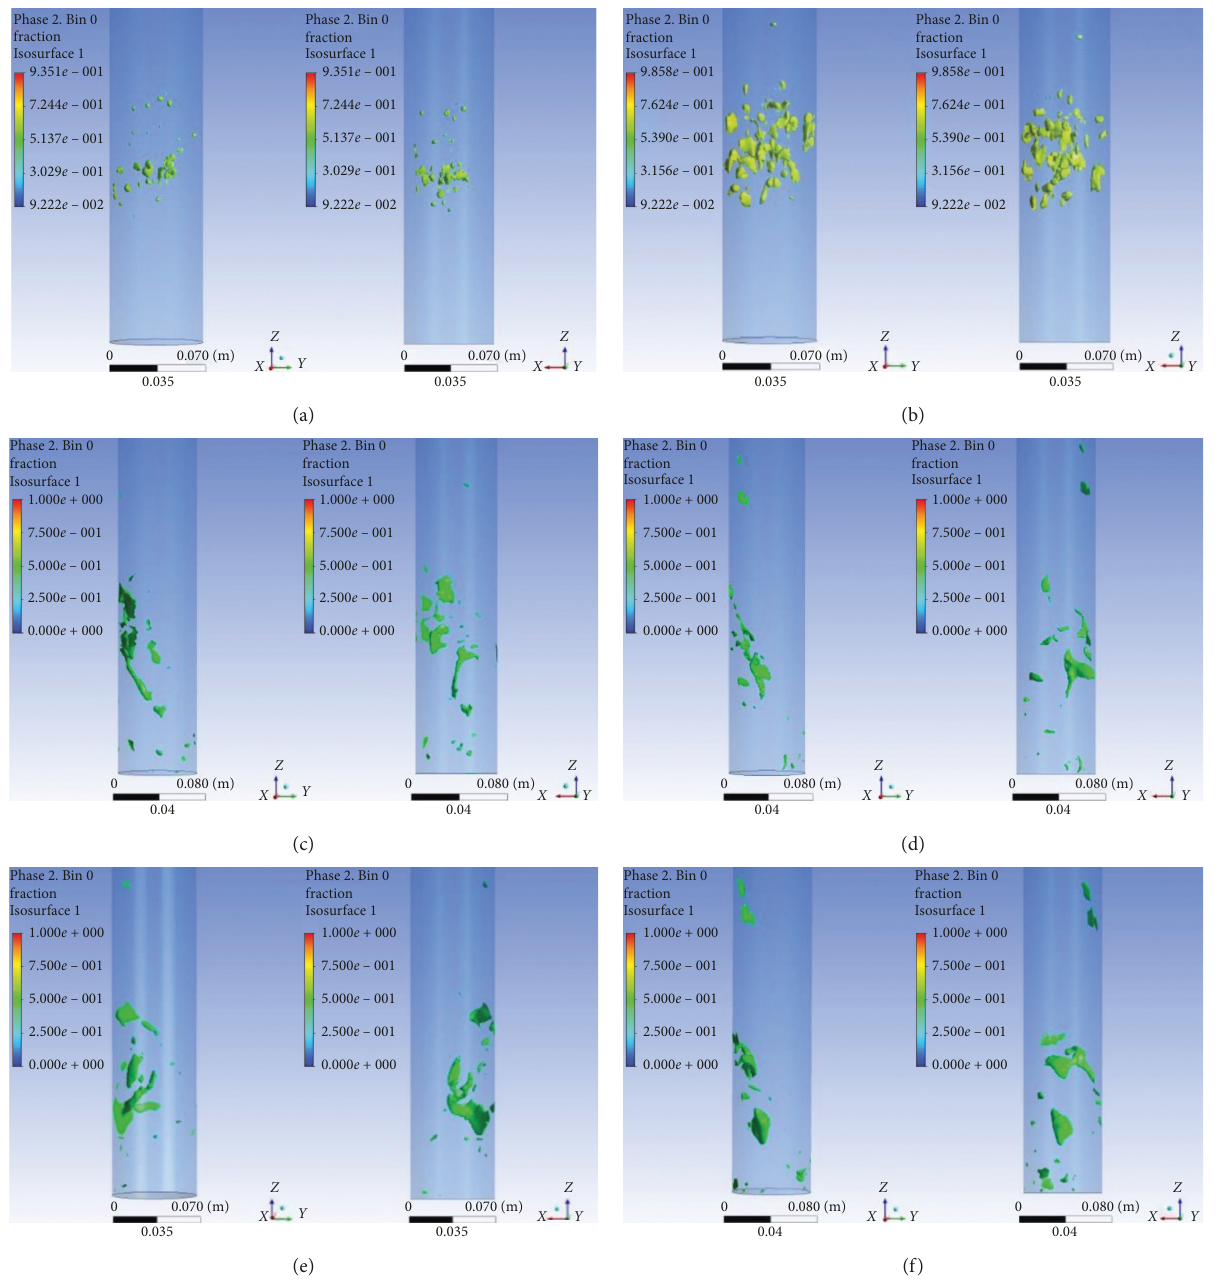
Figure 2: The process of flocculation and sedimentation between particles or flocs. Note that (a) and (b) represent the process of flocculation and sedimentation between particles at 5s and 10s, respectively. Images (c) and (d) represent the process of flocculation and sedimentation between microflocs at 15s and 20s, respectively. Finally, (e) and (f) represent the process of flocculation and sedimentation between macroflocs at 25s and 30s, respectively. (a) Time � 5s (particles). (b) Time � 10s (particles). (c) Time � 15s (microflocs). (d) Time � 20s (microflocs). (e) Time � 25s (macroflocs). (f) Time � 30s